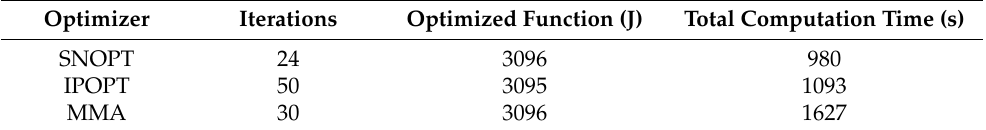
Table 3. Computational times for the three optimizers. Optimizer